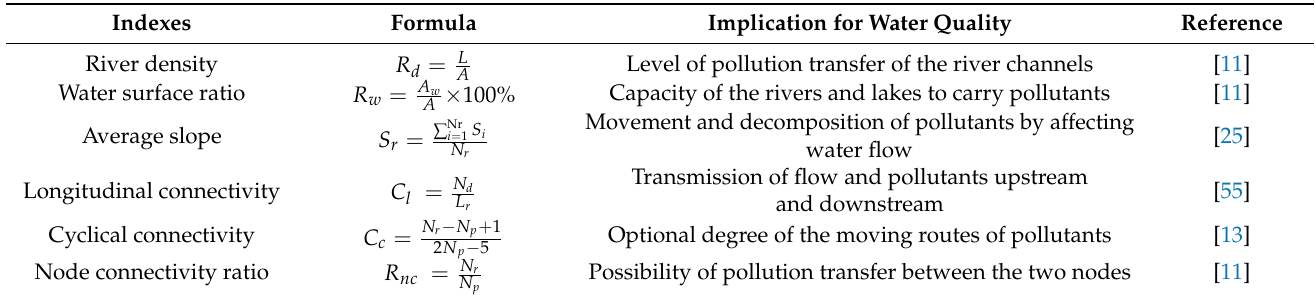
Table 1. Stream network structure and connectivity characteristics